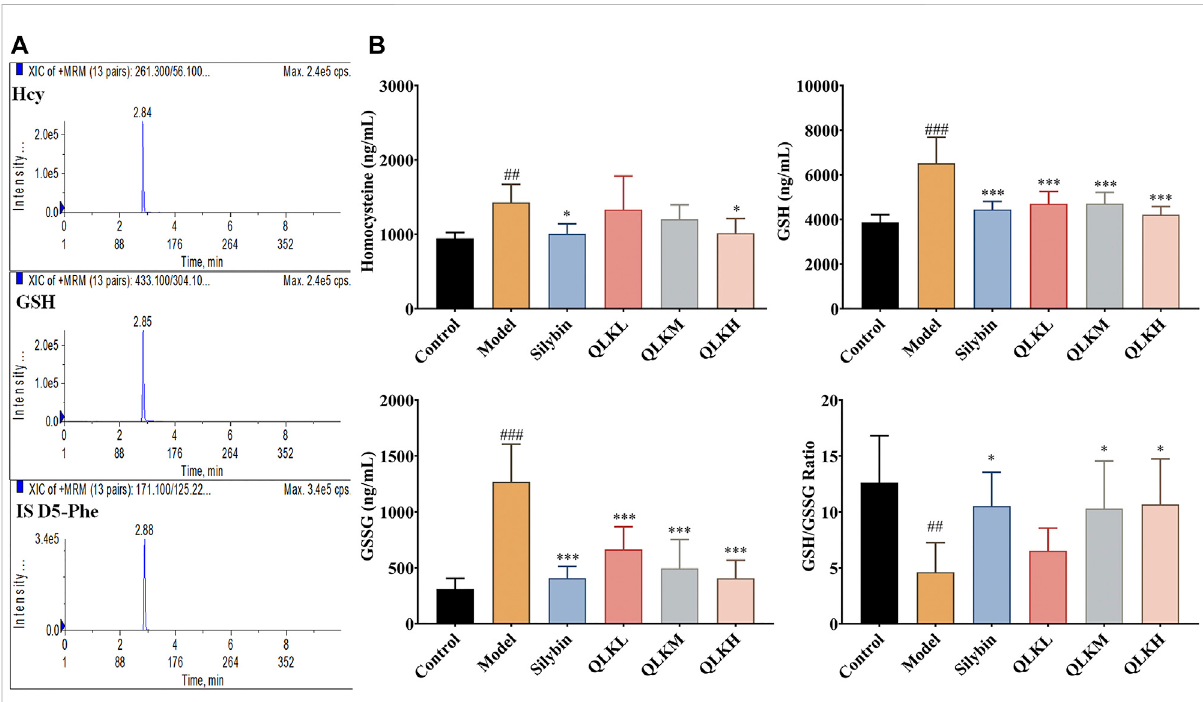
FIGURE 9 HPLC-MS/MSanalysisforserumHcy,GSH,andGSSGlevelsinmodelrats( n =6). (A) TypicalchromatogramsofHcy,GSH,andinternalstandard (D5-Phe); (B) SerumHcy,GSH,GSSGlevels,andGSH/GSSGratioinmodelrats. Valuesarepresentedasmean±SDfor threebiologicalreplicatesper group.* p < 0.05, *** p < 0.005 vs. model; ## p < 0.01 vs. control, ### p < 0.005 vs. control. Hcy, homocysteine; GSH, reduced glutathione.; GSSG, oxidized